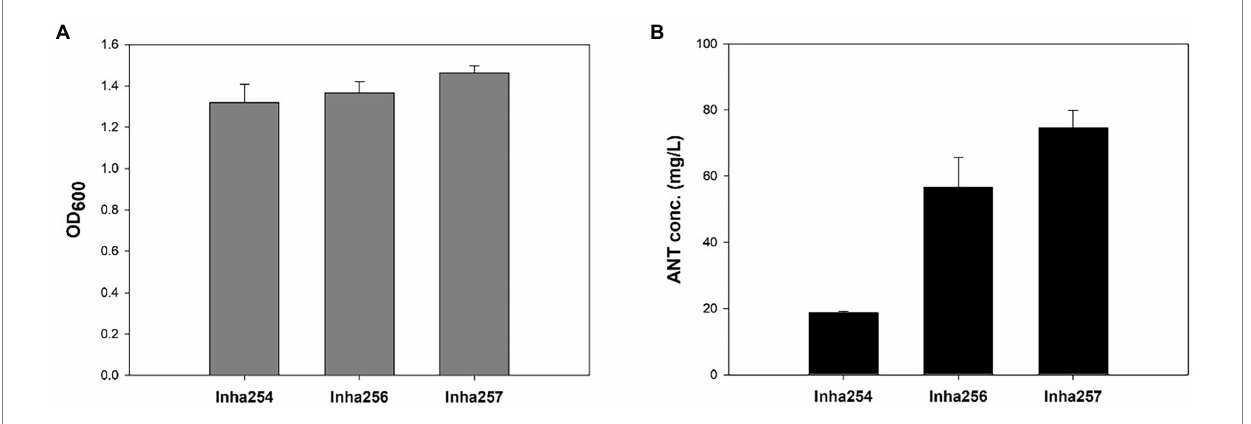
FIGURE 2 Comparison of cell growth and anthranilate production yields in recombinant E. coli strains (Inha254, Inha256, and Inha257) at 72 h miniature cultivation. (A) Cell growth as measured by OD600. (B) Quantitative analysis of anthranilate production